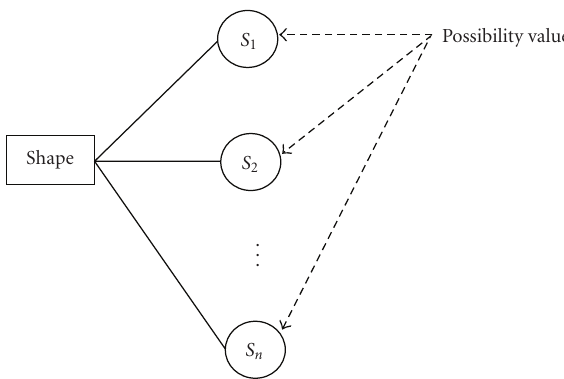
Figure 6: Structure of pattern matching with possibility calcula-